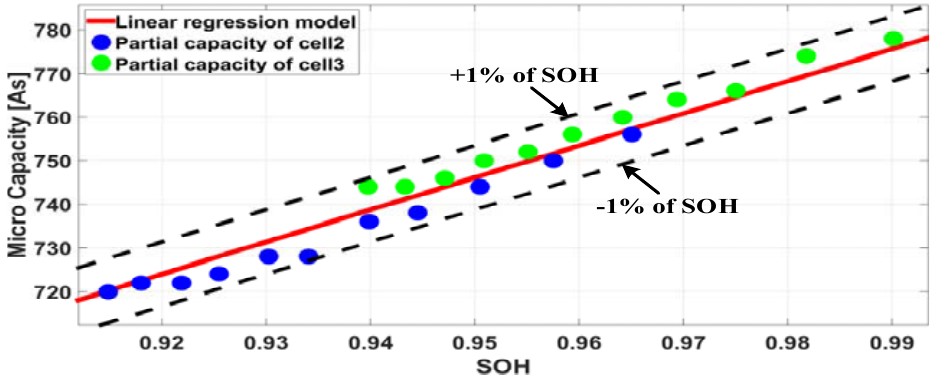
Figure 16. Comparison between the linear regression model based on the IC curve peak point of cell no. 1 and a real SOH based on two IC curve peak points of cell nos. 2 and 3.